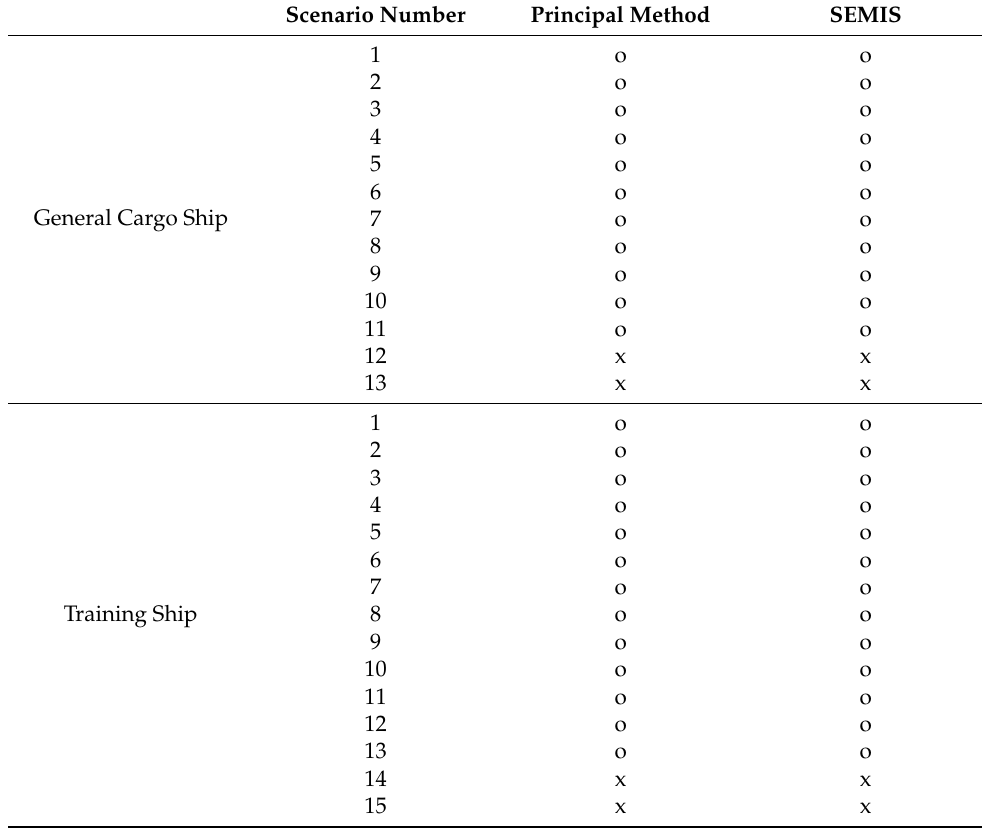
Table 9. Comparison of compliance with IMO intact stability regulations.